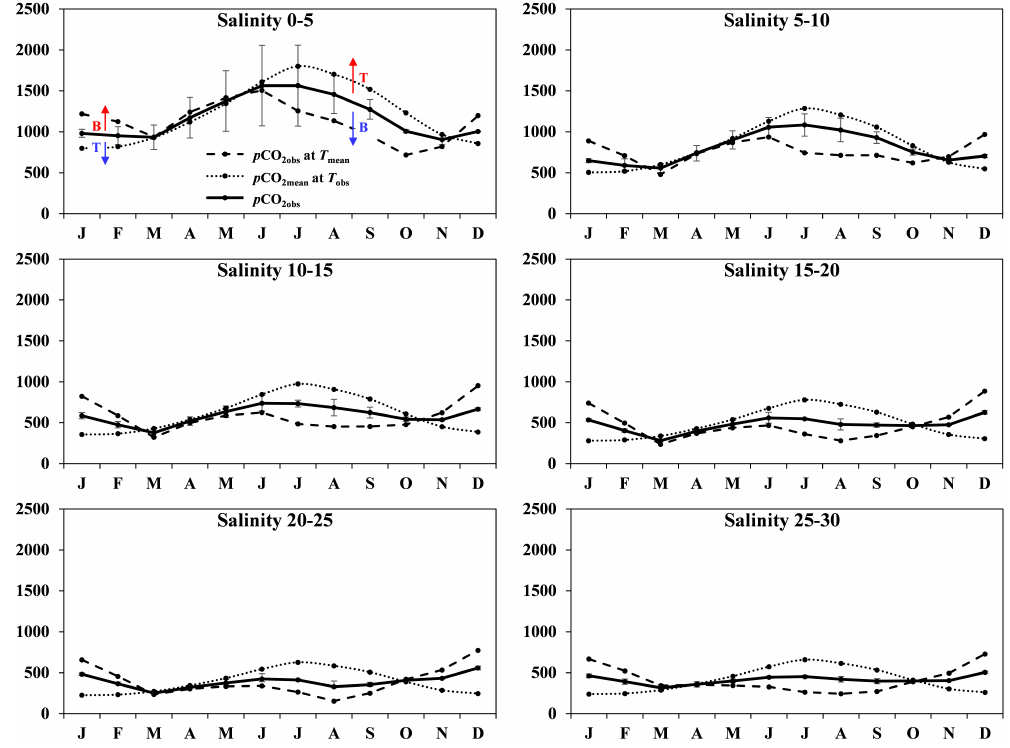
Figure 8. Salinity-binned intervals of temperature-normalized observed p CO 2 values at 13.3 ◦ C, annual mean, area-averaged p CO 2 values at in situ temperature, and observed p CO 2 values in the Delaware Estuary over the year. Red arrows indicate increases in p CO 2 and blue arrows indicate decreases in p CO 2 . The symbol T represents changes in p CO 2 due to thermal processes and the symbol B represents fluctuations in p CO 2 due to non-thermal processes. Error bars represent 1 standard deviation of the mean value for each month.